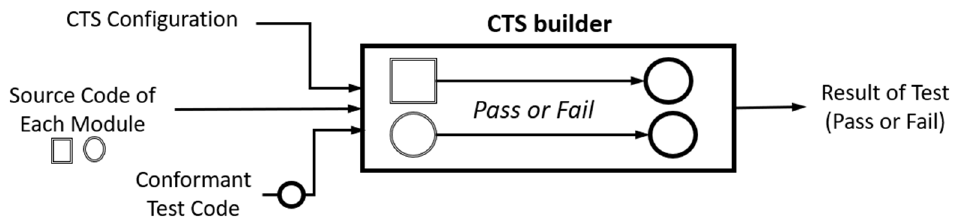
Figure 11. Specification of the FACE CTS. Table 7. A test result of the FACE CTS.